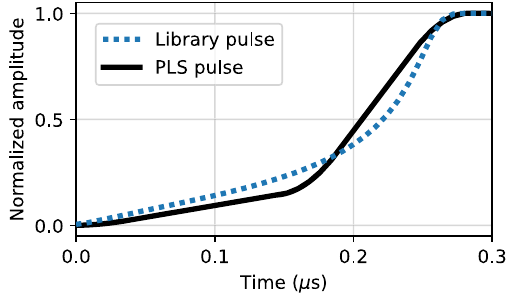
Fig. 3 An example of a simulated PLS pulse (solid line) and library pulse (dotted line), each with a rise time of 280ns